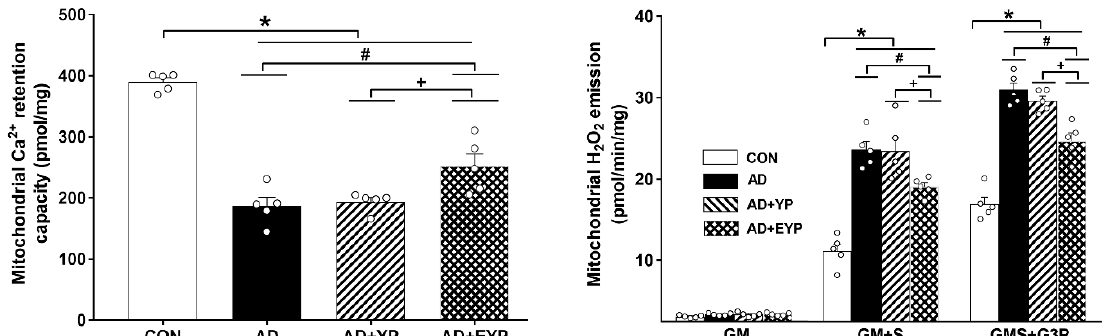
Figure 4. Effect of plasma from young exercised mice on mitochondrial Ca 2+ retention and H 2 O 2 emission in hippocampus. CON: wild-type, AD: 3xTg-AD, AD + YP: 3xTg-AD and young plasma injection, AD + EYP: 3xTg-AD and exercised young plasma injection group. Data are expressed as the mean ± standard error of the mean (SEM). * p < 0.05 compared to the CON group. # p < 0.05 compared to the AD group. + p < 0.05 between the AD + YP and AD + EYP groups. 2.5. Effect of Plasma from Young Exercised Mice on Apoptosis in the Hippocampus levels of Bax, Bcl-2, cytochrome c, apaf-1, and cleaved caspase-3 and -9. To investigate cell death, we